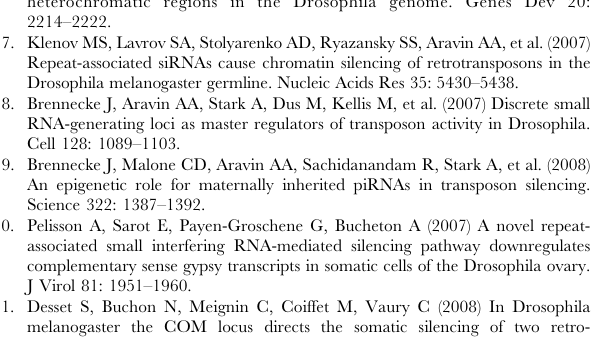
were calculated using the equation: D Ct=Ct RPL37 2 Ct LNCR relative copy numbers with the formula 2 D Ct . Figure S5 The presence of histone H3 modification during different developmental stages of S. frugiperda . during the different developmental stages of S. frugiperda (E1- 1 day